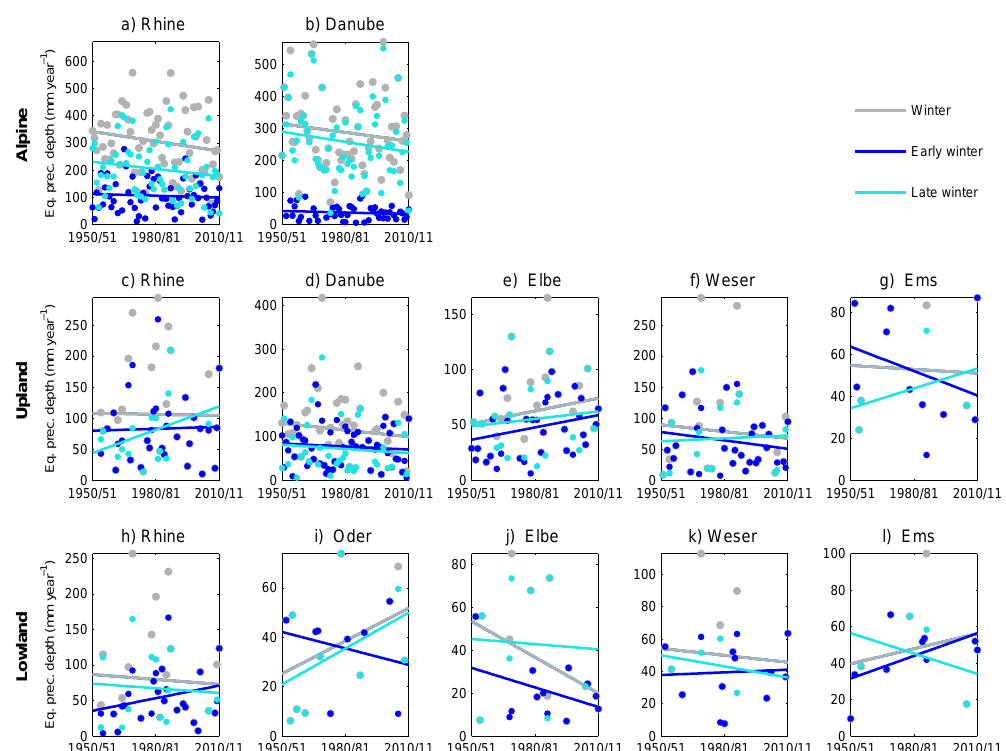
Figure 5. Total equivalent precipitation depth for all selected RoS events in the winter (November–May), in the early winter (November– February), and in the late winter (March–May) for the period 1950–2011. Only the years with RoS events are represented.